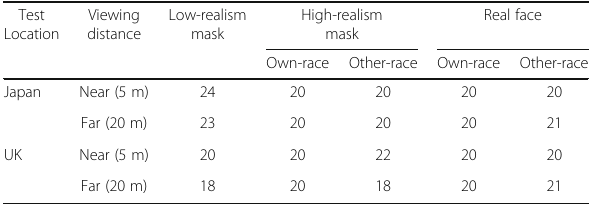
Descriptives Table 1 summarizes the distribution of participants across conditions. Table 1 Number of participants tested in each of the 10 different conditions in Experiment 3, shown separately for testing in UK and Japan. Note that the Own-race / Other-race distinction does not apply to the Low-realism mask